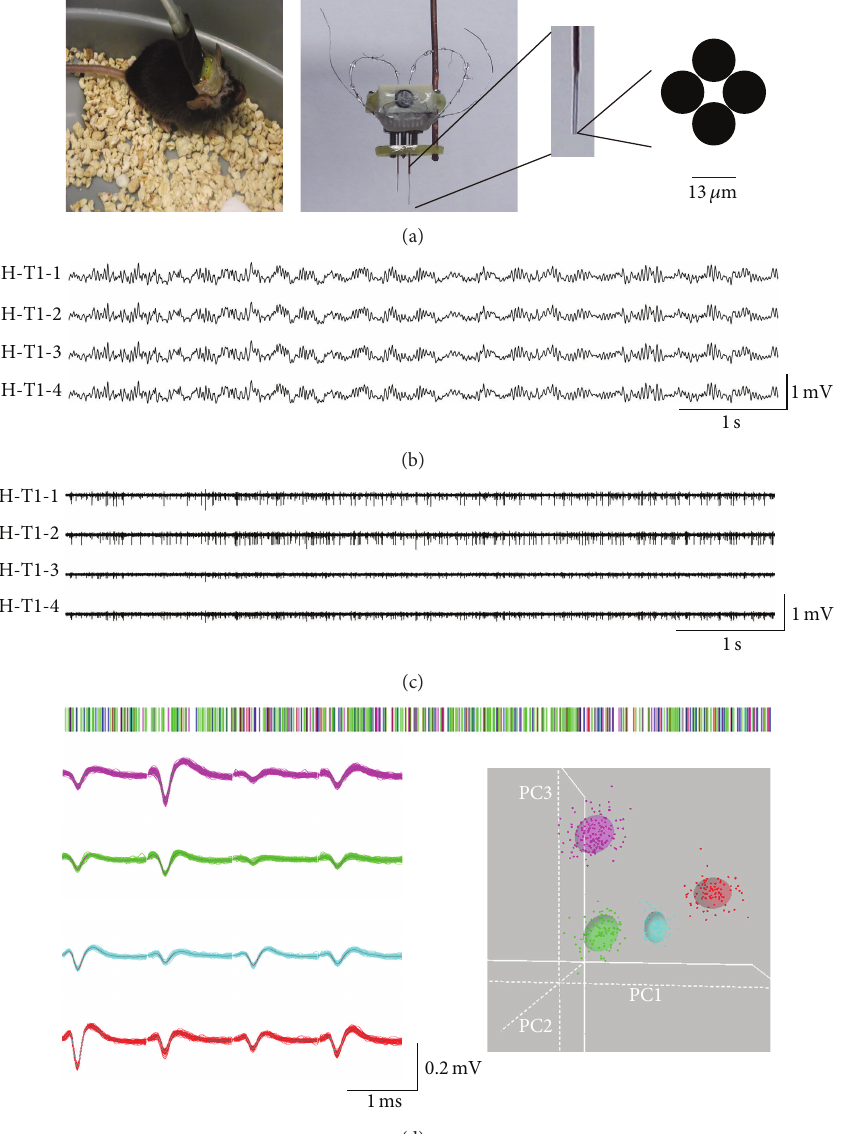
Figure 1: Multichannel microelectrode recordings. Two bundles of electrodes were inserted into the CA1 region of the left hippocampus and PF region of the left thalamus, respectively. Each bundle consists of two tetrodes and each tetrode is formed of four insulated nickel-chrome alloy electrodes (diameter of 13 𝜇 m, impedance of 0.5–1.0 M Ω ). For each electrode, we extracted single-unit activities and LFPs. Single-unit activities were obtained by filtering the recording at 300–6000 Hz and sorting the filtered data using OfflineSorter software (Plexon Co, USA). To obtain the LFPs, we filtered the data at 0.5–100 Hz. (a) Multichannel microelectrode. The enlarged view shows one bundle of electrodes consisted of two tetrodes and the cross-section through a tetrode. (b) LFPs from a tetrode in the normal hippocampus. (c) Multiunit activity (MUA) of the same tetrode. (d) Example of single-unit activity. The upper trace is the spike train sorted from the MUA in (c). The spikes were from four neurons denoted by four colors. The left bottom traces show the superimposed single waveforms of spikes of four neurons. The right bottom figure shows the four clusters in the feature space, which were projected by the spikes of the four neurons, by using the principal component analysis (PCA) method. H, hippocampus; T, thalamus; T1&T2, Tetrode 1 and Tetrode 2 in a bundle. For example, H-T1-2 means the second channel of Tetrode 1 in